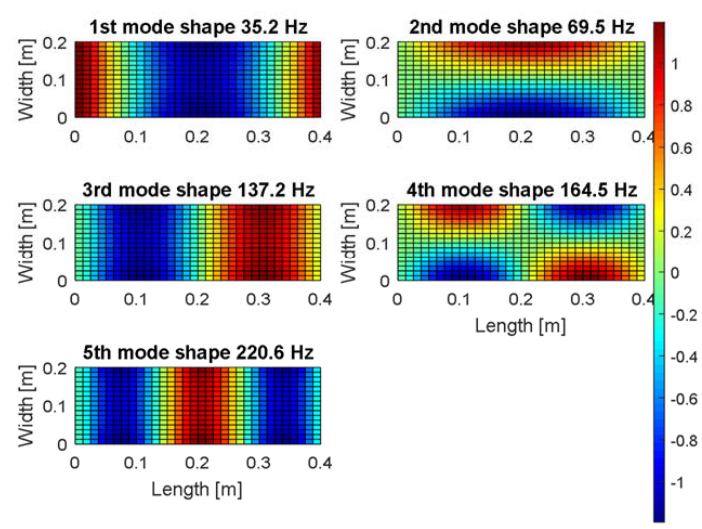
Figure 3. The mechanical strains fields in X direction of the smart SFSF plate with integrated piezo-elements for the first five mode shapes.